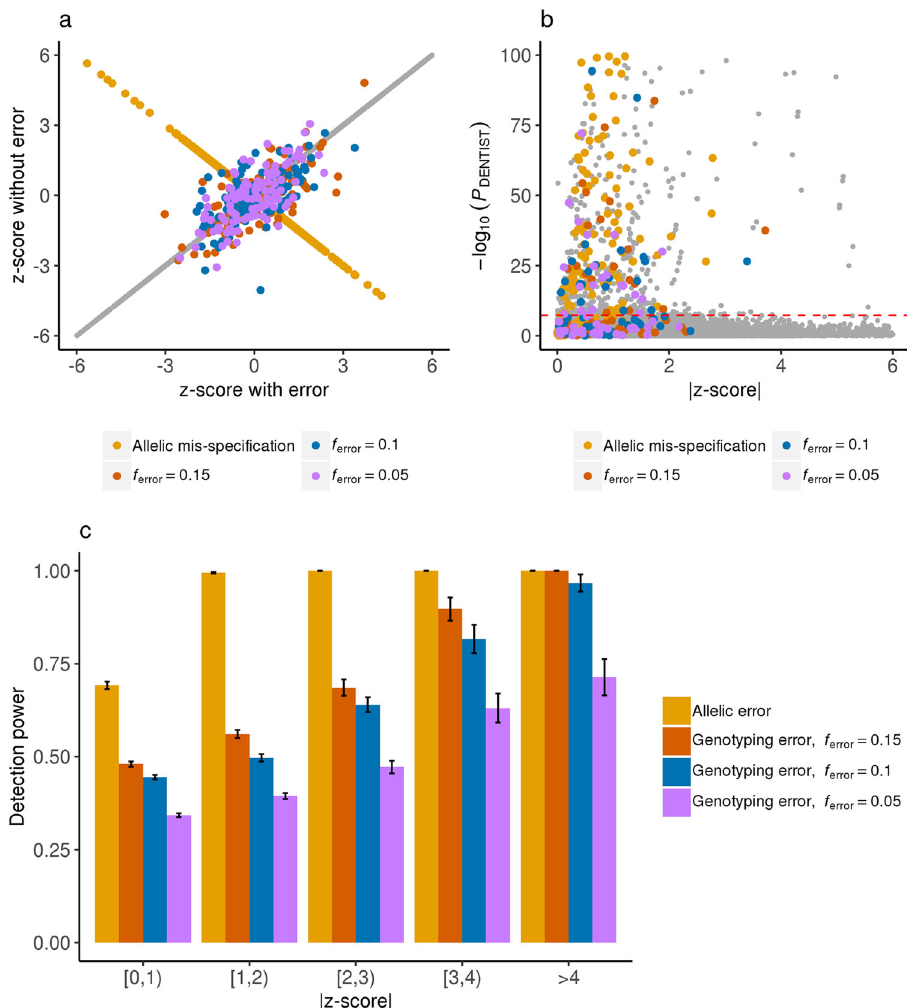
Fig. 1 Detecting simulated allelic and genotyping errors using DENTIST. We assessed the power of DENTIST in detecting allelic and genotyping errors by simulation. There are three levels of genotyping error rate ( f error = 0.15, 0.1, or 0.05), de fi ned as the proportion of individuals with erroneous genotypes for a variant. a is a plot of the GWAS z-scores from data with simulated errors against those from data without such errors. The gray dots in the diagonal represents z-scores of variants without errors. In ( b ), the DENTIST P values are plotted against the absolute values of the GWAS z-scores for all the variants. The horizontal dashed line corresponds to P ¼ 5 ´ 10 (cid:2) 8 . c , the height of each bar represents the power in a |z-score| bin estimated from 200 simulation replicates, with the error bar representing ± one s.e. of the estimate. Source data are provided as a Source Data fi